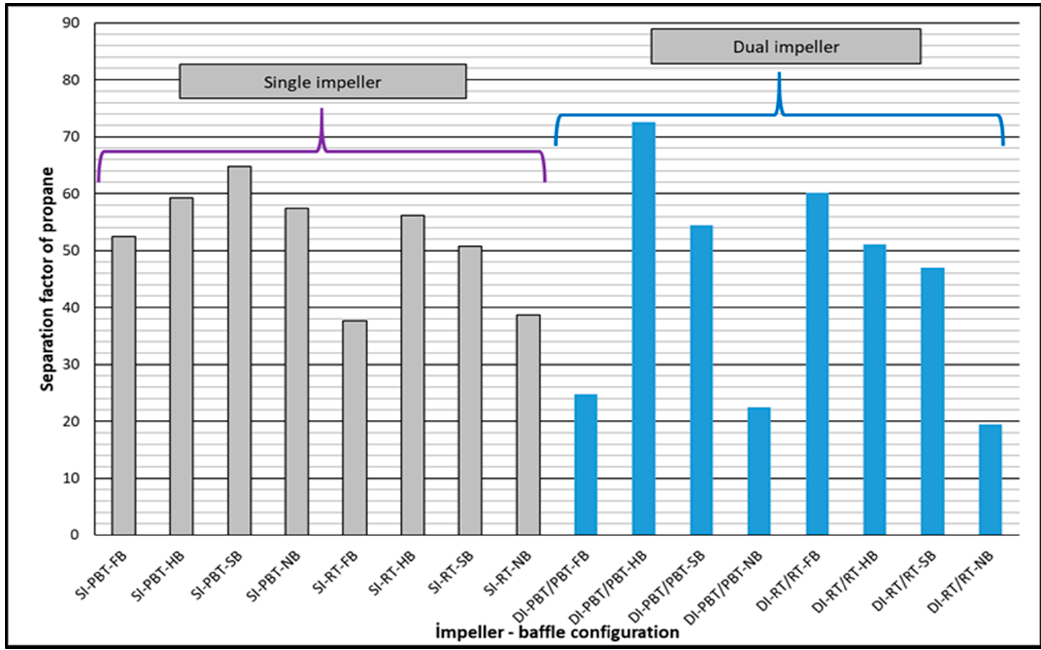
Figure 8. Separation factor of propane for single and dual impeller experiments (experimental temperature 2 °C).